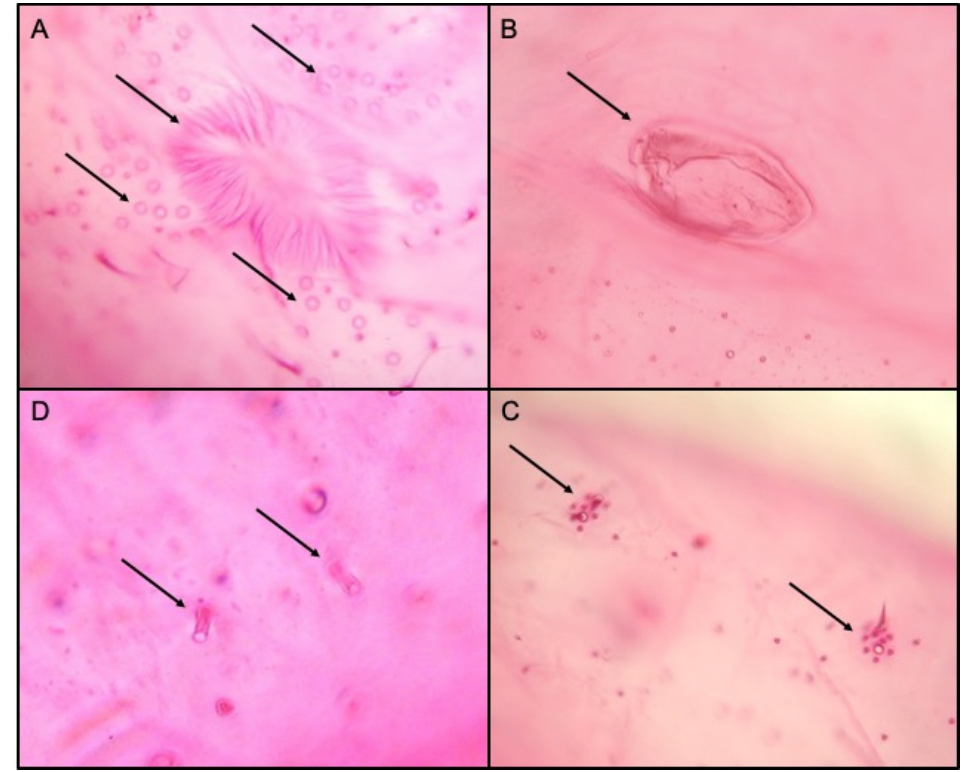
Figure 3. Morphological features of Phenacoccus solenopsis , the vulva and multilocular disc pores ( A ), circulus ( B ), cerari ( C ) and oral collar tubular ducts ( D ). circulus ( B ), cerari ( C ) and oral collar tubular ducts ( D